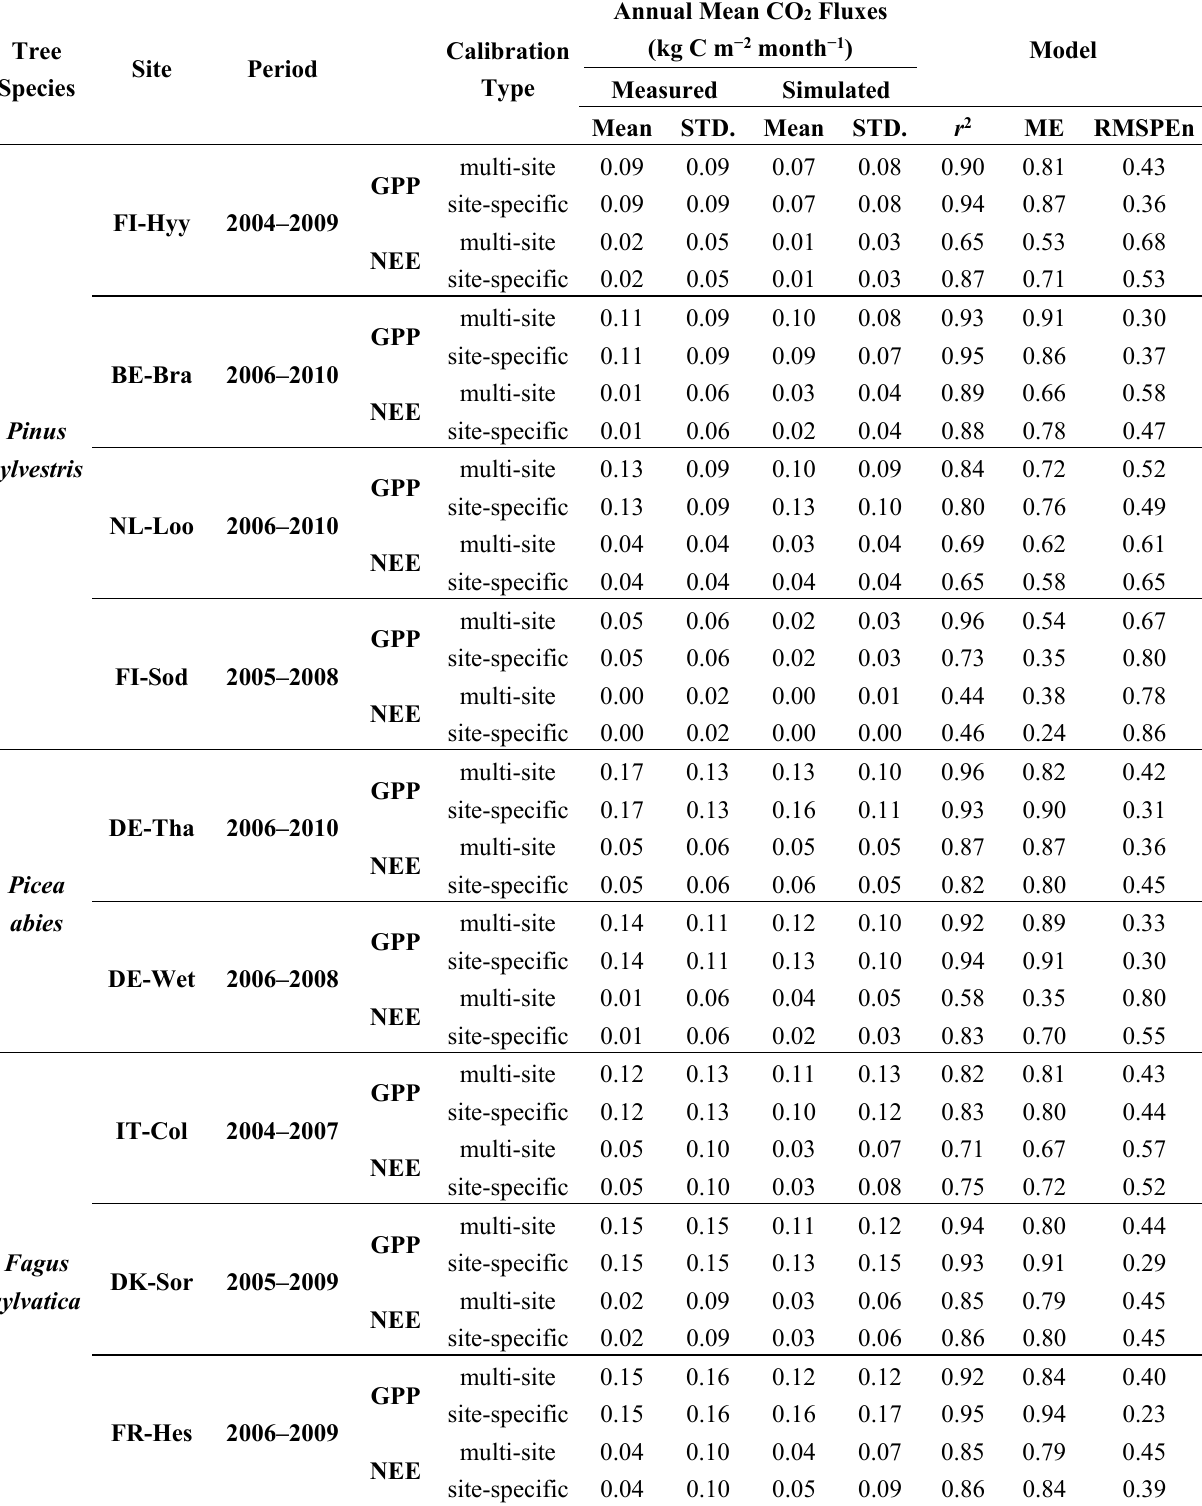
Table 7. Averaged annual means of monthly aggregated measured and simulated GPP and NEE fluxes obtained with either site-specific or multi-site parameters. Abbreviations: ME: model efficiency, RMSPEn: normalized root mean square prediction